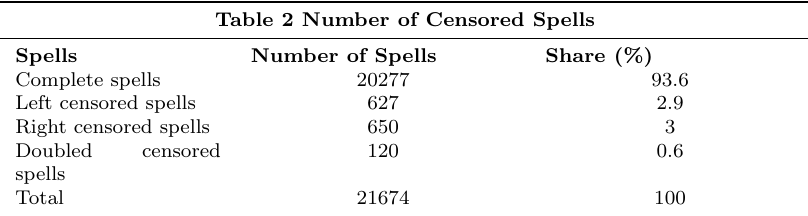
Table 2: Number of Censored Spells Table 2 Number of Censored